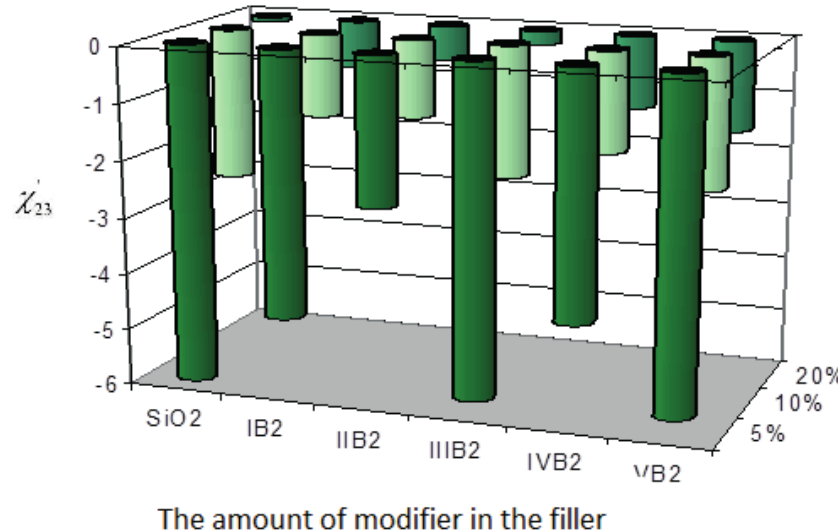
Figure 2: Dependence of (chloroform) on the amount of modifier in filler at 363K (I, II, III, IV, V denotes 1, 2, 3, 5, 10% of modifier in filler B2).